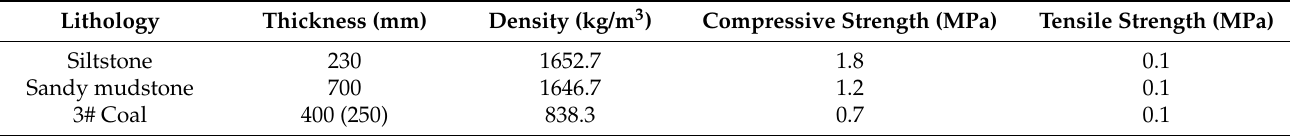
Table 2. Thickness and mechanical parameters of physical model.